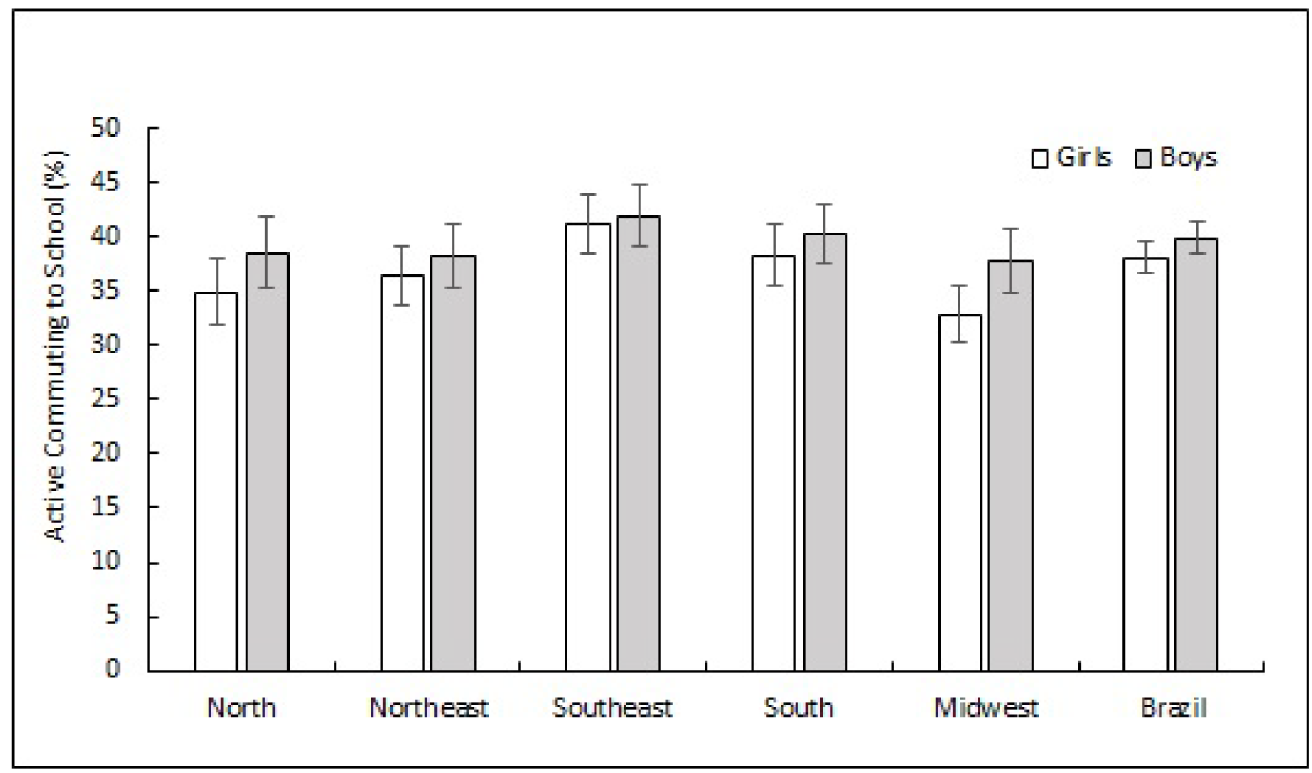
Figure 1- Prevalence of active commuting to school according to geographical region and